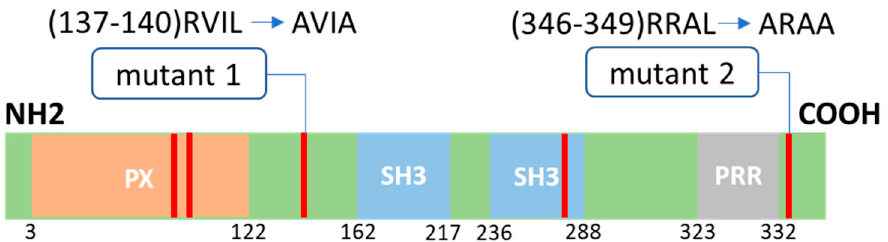
Figure 1. Noxo1 structure and D-box mutations. Noxo1 sequence contains four functional domains, including one phosphoinositide-binding structural domain (PX, orange), two Src homology 3 domains (SH3, blue), one proline-rich region (PRR, grey), and five putative D-box motifs (RXXL, red lines). We generated two mutants of Noxo1 as indicated, mutant 1 (mut1) and mutant 2 (mut2), with the mutation of the two D-box present in the unstructured part of the protein (green).